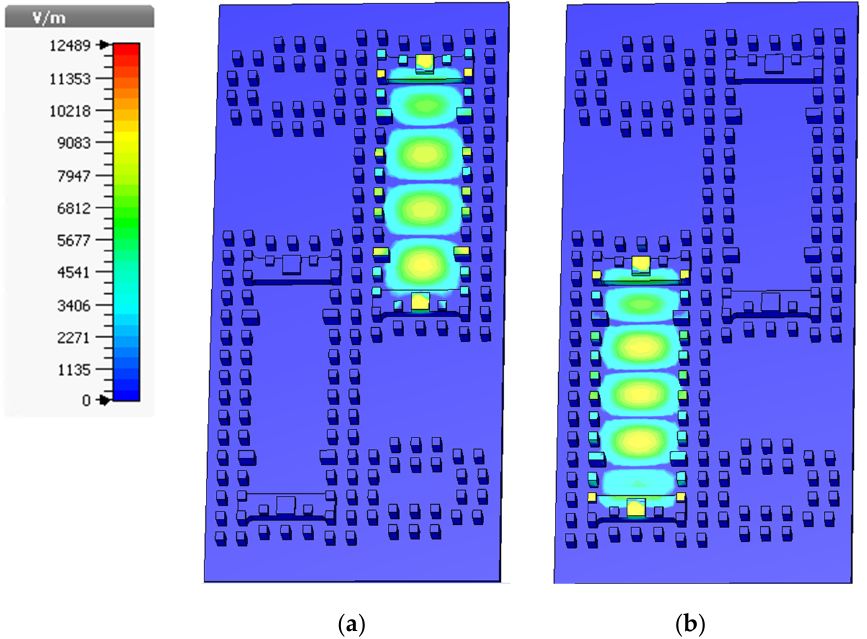
Figure 6. The simulated electric field distribution by excitation of the pole-port in ( a ) State A and ( b ) State B.